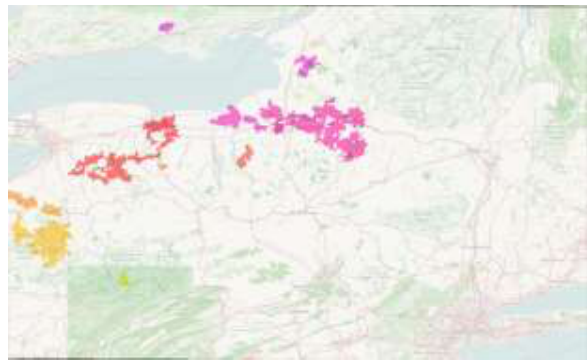
Figure 13. Storm elements for 11Z July 1, 2017 (compare with Figure